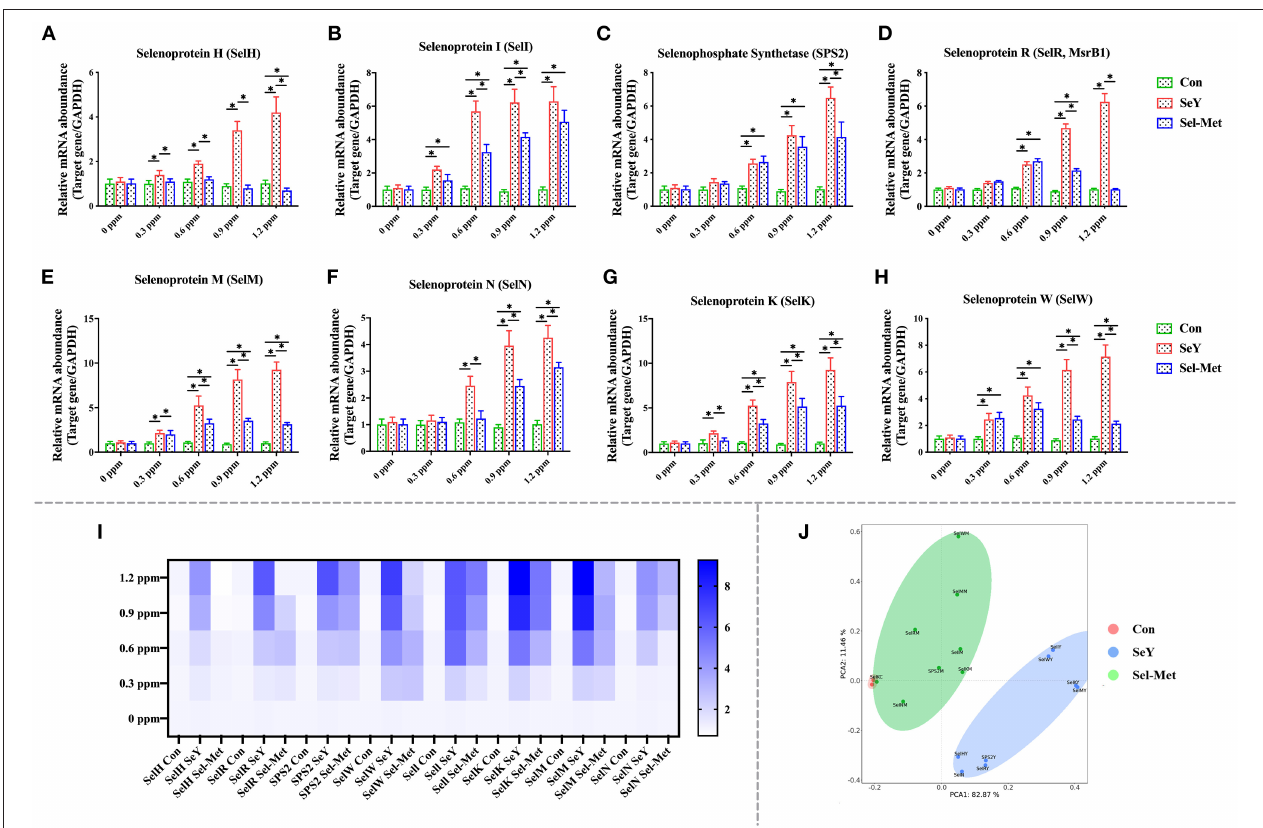
FIGURE 5 | Effects of SeY and Sel-Met addition on mRNA expression of SelH, Sell, SPS2, SelM, SelN, SelK, SelR, and SelW in PMECs. The cells were incubated with different concentrations of SeY and SEL-Met (0, 0.3, 0.6, 0.9, and 1.2 ppm) for 24h, respectively, and then collected for detection. Data were expressed as mean ± SEM ( n = 6), and * indicated statistically significant difference ( P < 0.05). (A–H) qPCR was used to detect the mRNA expression levels of SelH, Sell, and other selenium proteins. (I) Heat map comparison of mRNA expression levels of SelH, Sell, and eight other selenoproteins. (J) PCA score plot results the mRNA